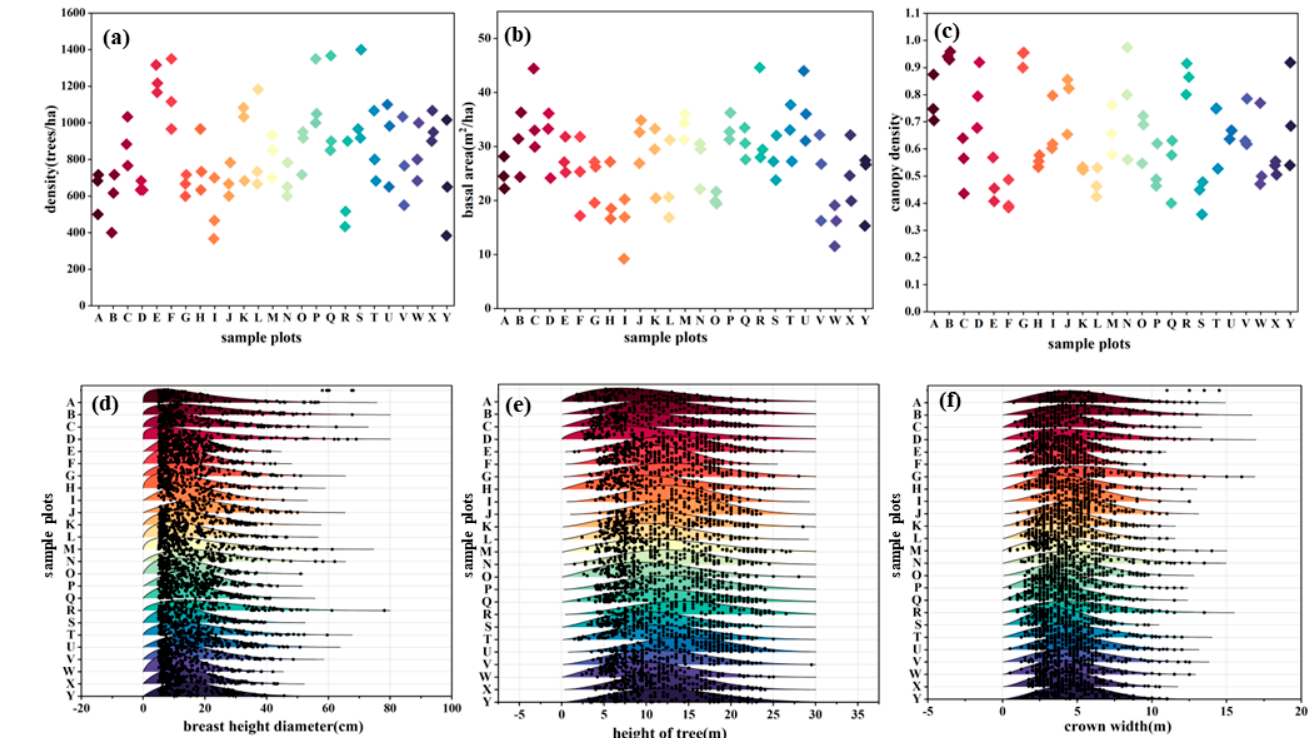
Figure 2. Community structure characteristics of the arbor layer. ( a – c ) Data distribution of density, basal area and canopy density of three quadrats in sample plots; ( d – f ) data distribution and Weibull curve of DBH, tree height, and crown width. In ( d − f ), the vertical axes represent the plot numbers A–Y of the survey sample.